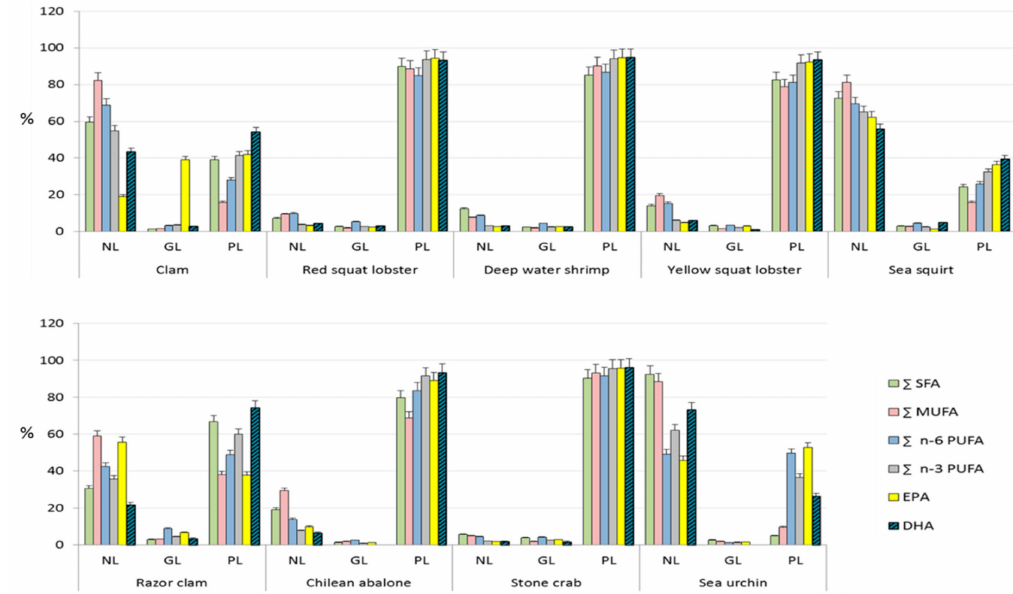
Figure 3. Distribution (% in each lipid class of total lipids) of SFA, MUFA, n-6 PUFA, n-3 PUFA, EPA and DHA among di ff erent lipid classes in extracted shellfish lipids. Σ n-3 PUFA includes EPA and DHA. Both n-3 PUFA are displayed separately because of their nutritional relevance. NL: neutral lipids; GL: glycolipids; PL: